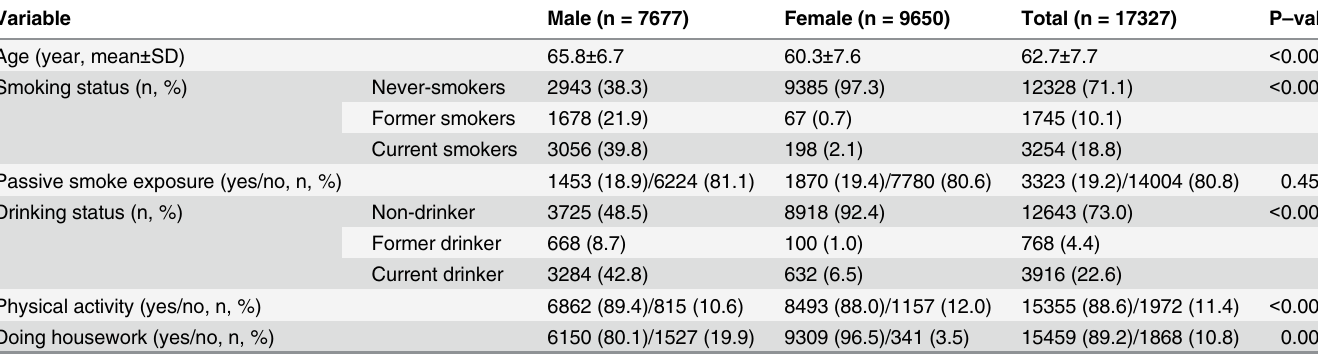
Table 1. The socio-demographic and personal characteristics of